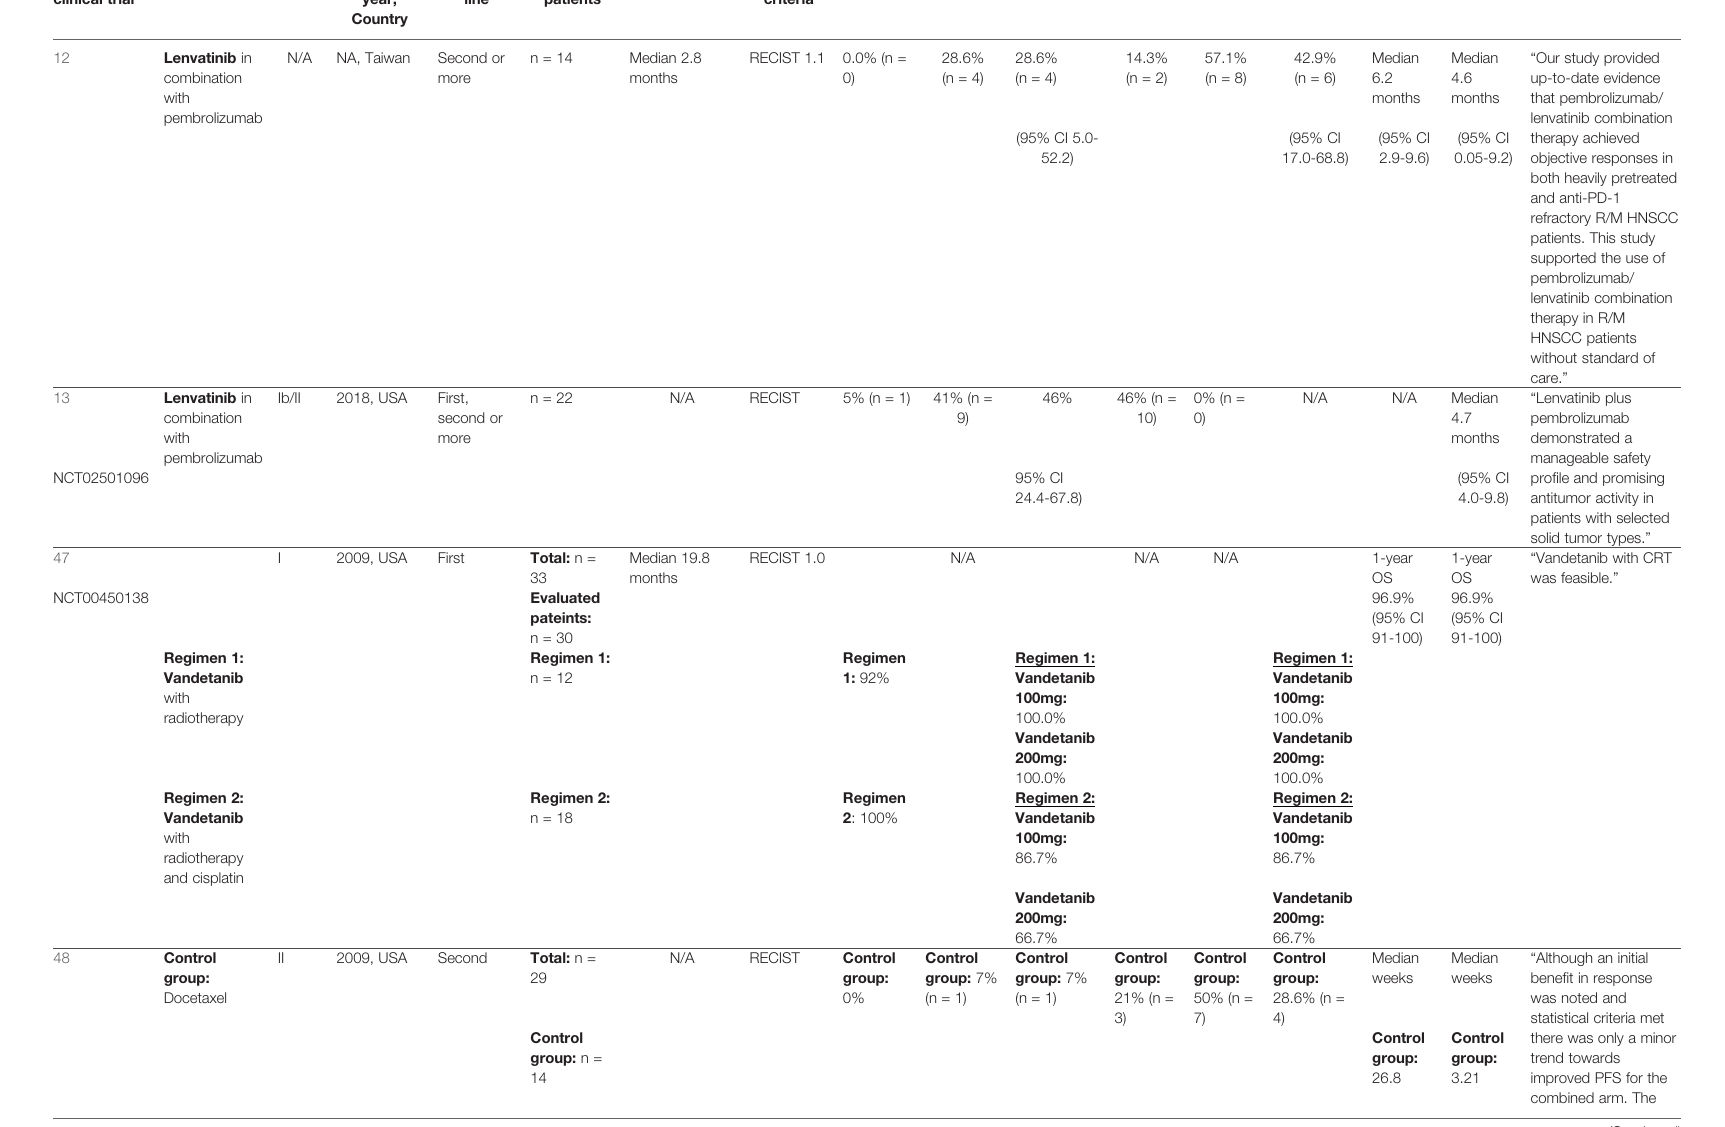
TABLE 4 | Summary of the other tyrosine kinase anti-angiogenesis inhibitors clinical trials for head and neck squamous cell carcinoma. Reference, clinical